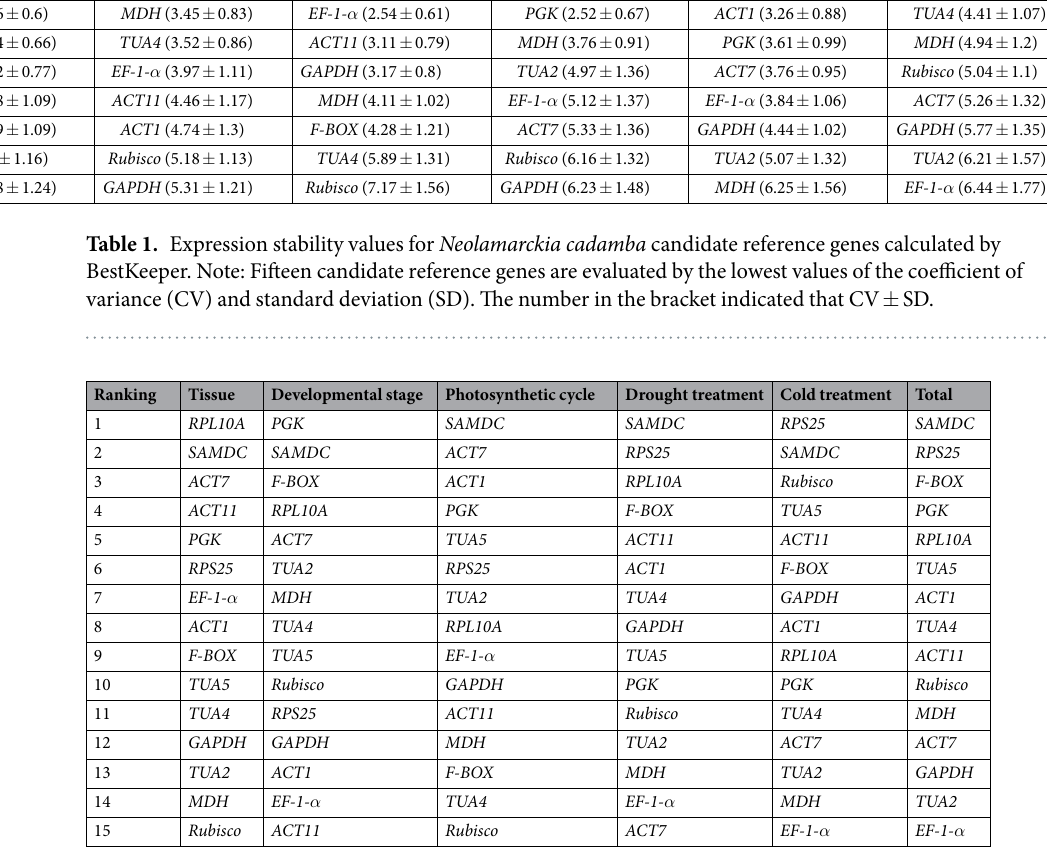
Table 2. Comprehensive ranking of 15 candidate reference genes integrated by